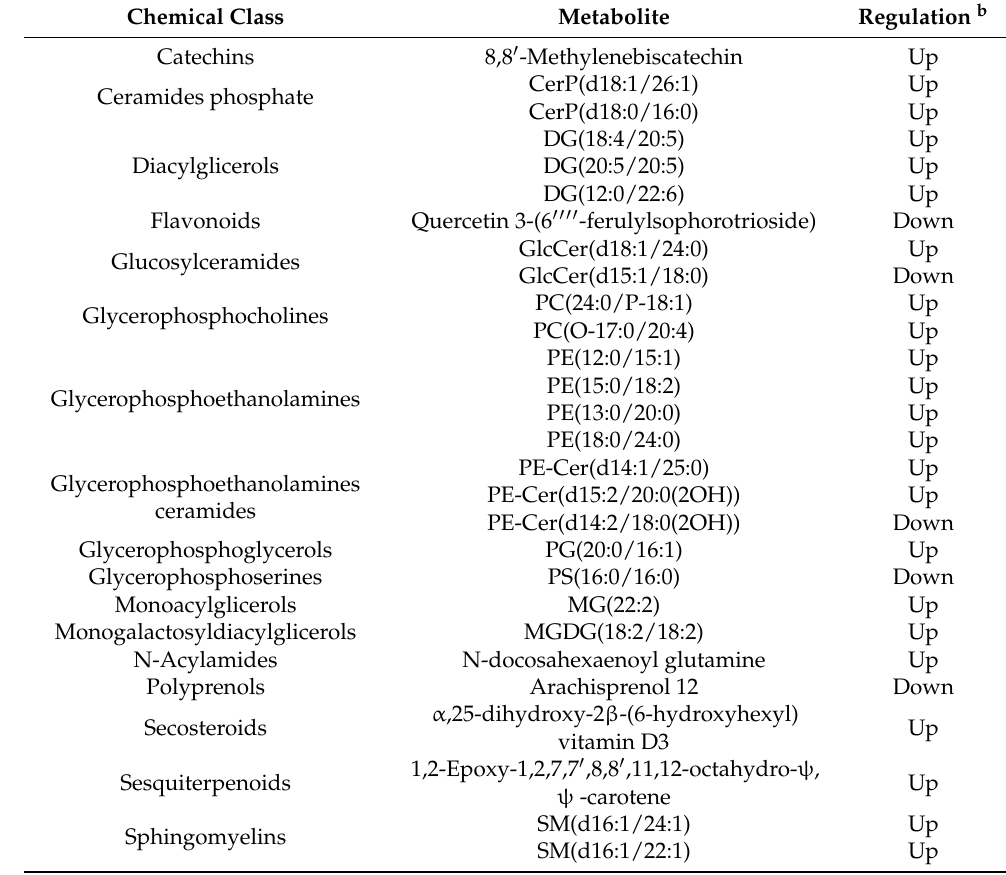
Table 2. Main discriminant metabolites a in the milk of goats fed SCG vs. control detected in the positive ionization mode.